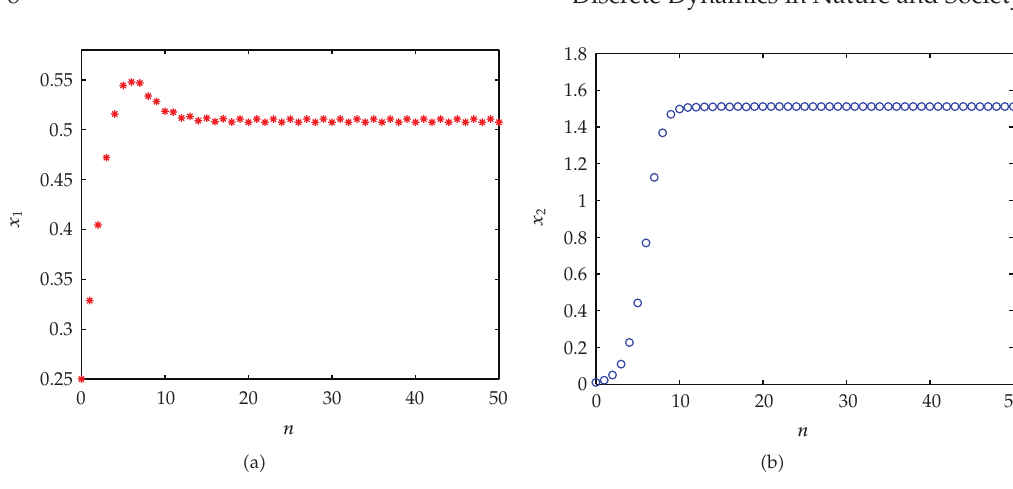
Figure 1: Permanence of system (cid:6) 1.2 (cid:7) with initial value (cid:6) 0 . 25 , 0 . 01 (cid:7) . (cid:6) a (cid:7) Time series of x 1 for n ∈ (cid:2) 0 , 50 (cid:3) . (cid:6) b (cid:7) Time series of x 2 for n ∈ (cid:2) 0 , 50 (cid:3)